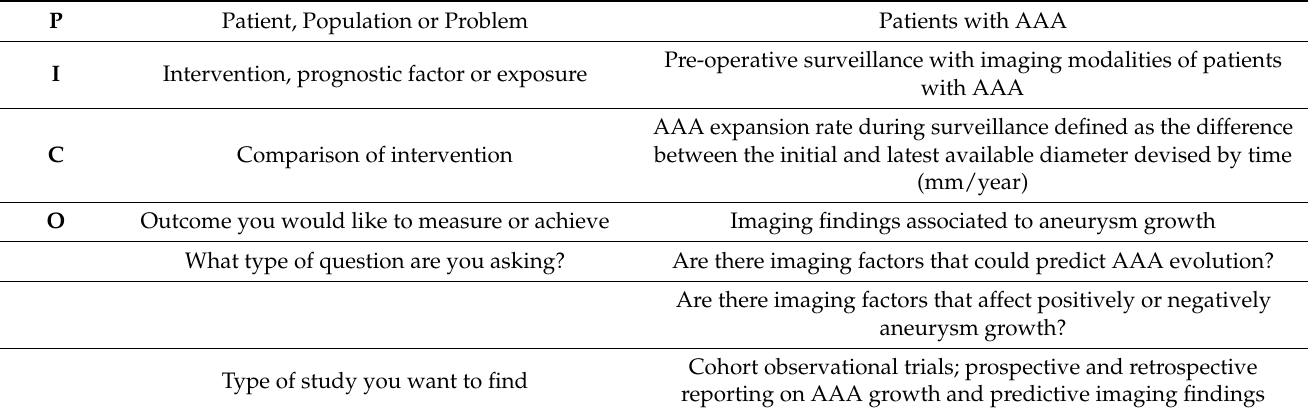
Table 1. P.I.C.O. (patient; intervention; comparison; outcome) model was used to define the clinical questions and clinically relevant evidence in the